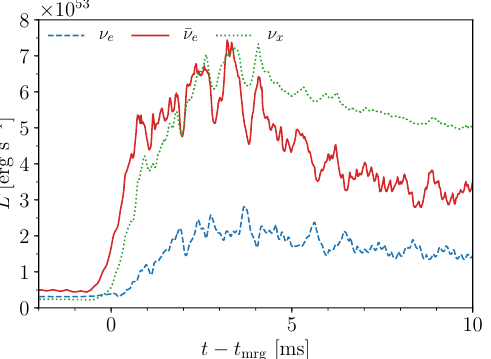
Figure 11. Neutrino luminosity evolution for the BHB Λ φ - ν simulation. Similarly to the short inspiral simulations, we have peak luminosities at ∼ 2–3 ms after the merger, followed by a decrease towards the end of the